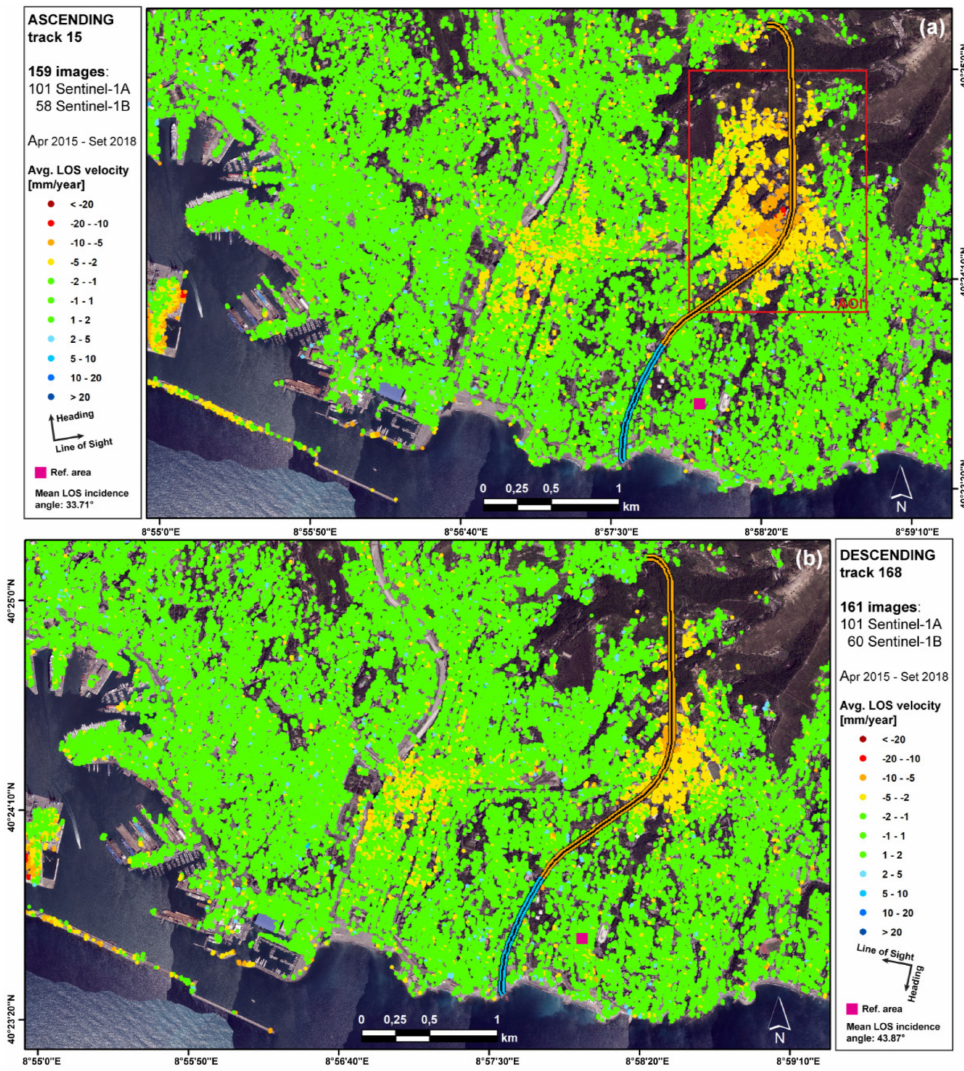
Figure 4. Average 2015–2018 velocity maps of displacement in the Genoa area. In ( a ) and ( b ) LOS velocities in mm/years are reported. Green points indicate stable areas. Ground subsidence is clearly visible in the area of interest (red